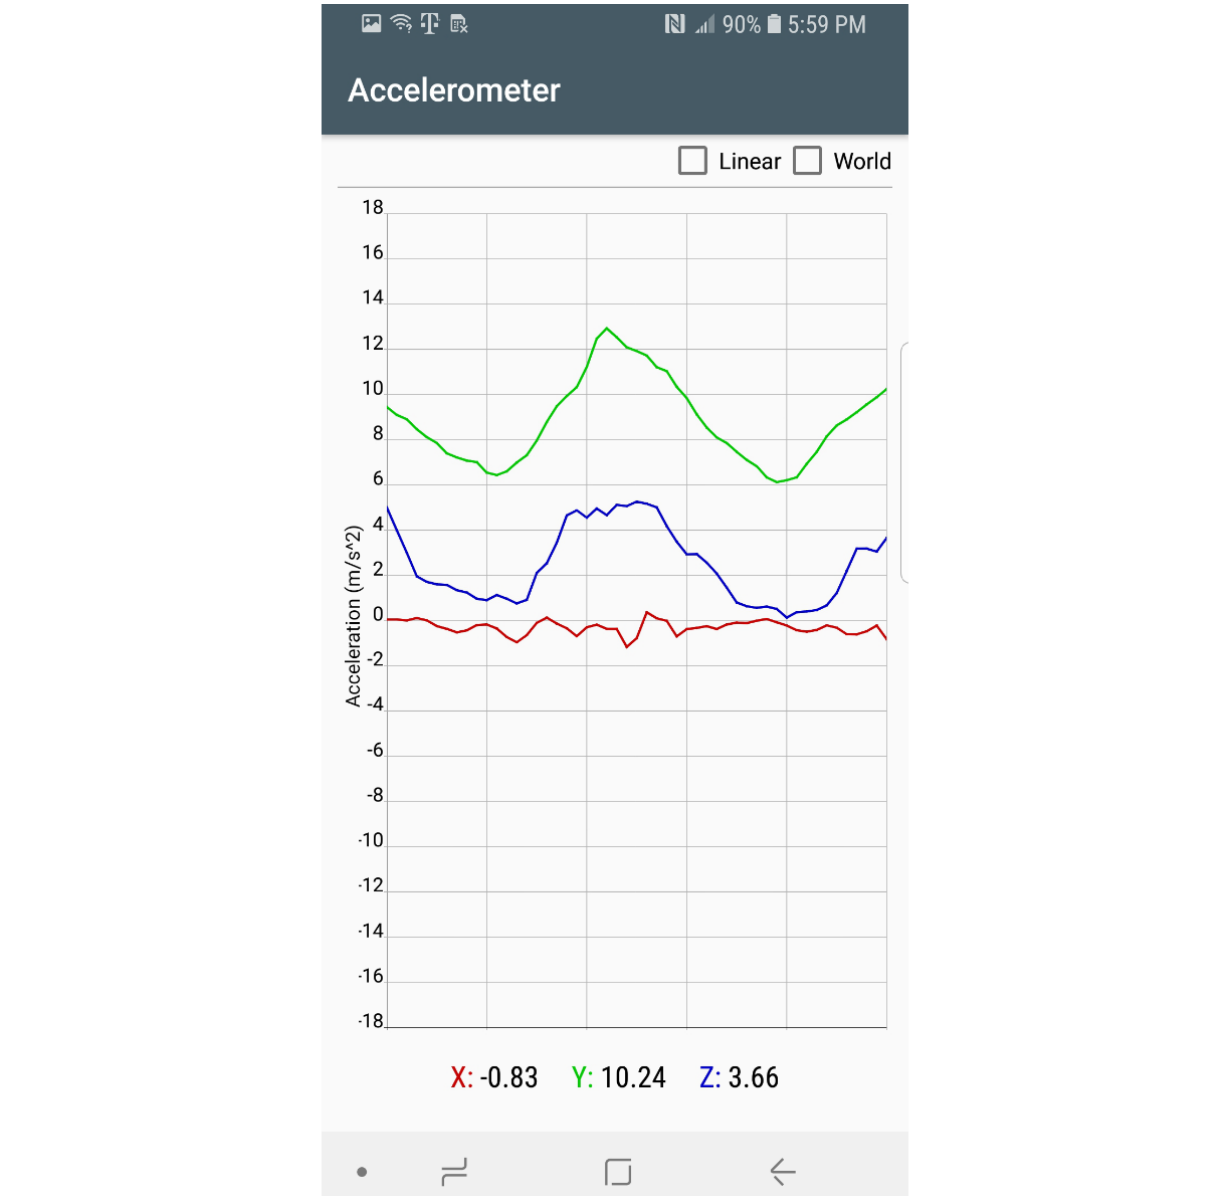
Figure 7. Sensor data